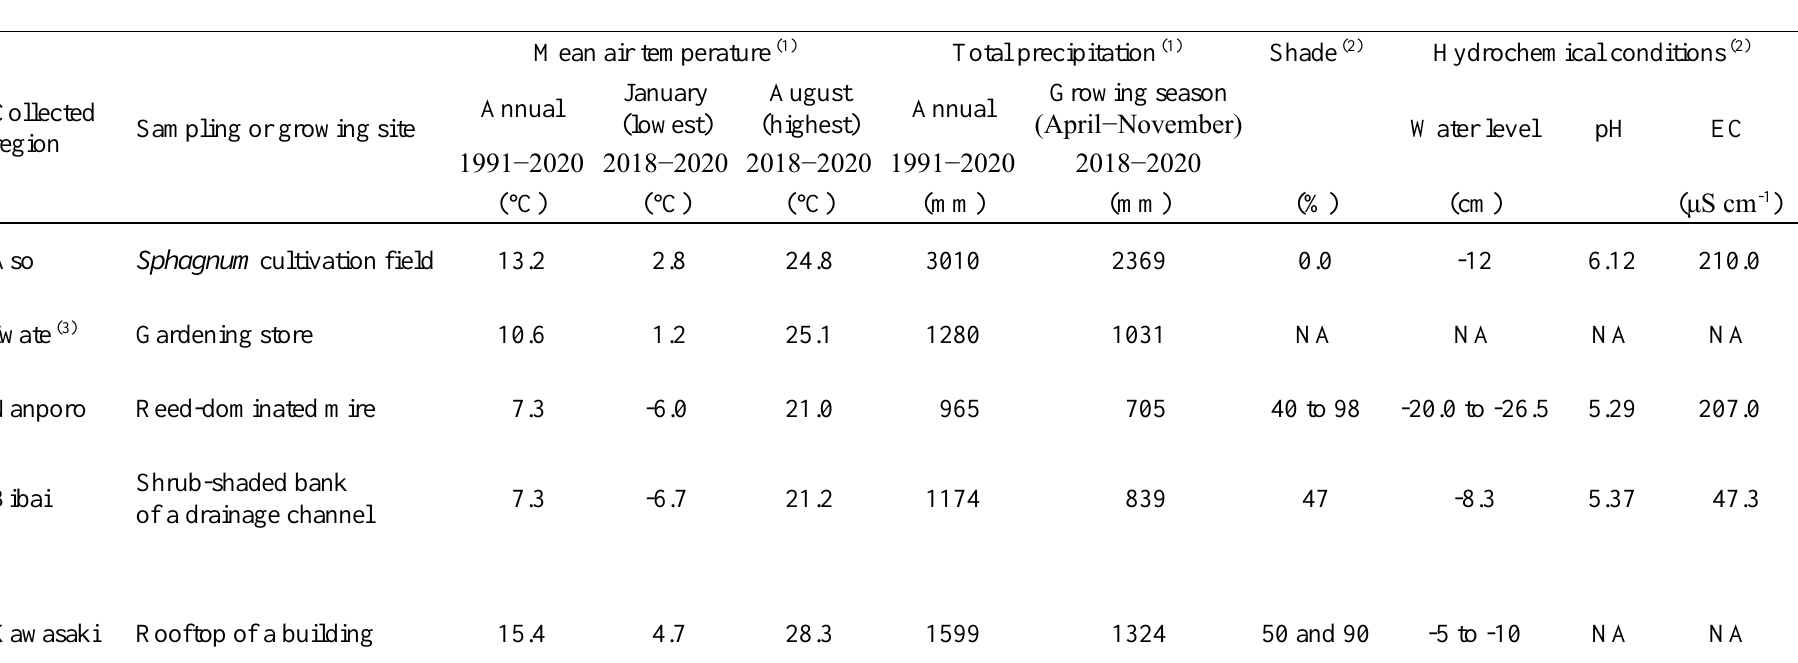
Table 1 . Climate, micrometeorological and hydrochemical conditions at the sites from which Sphagnum was sampled and at the growing site on the rooftop of a building in Kawasaki. Shade is expressed as the quotient of PPFD incident on the Sphagnum and the global PPFD measured above the shading material. NA = no data